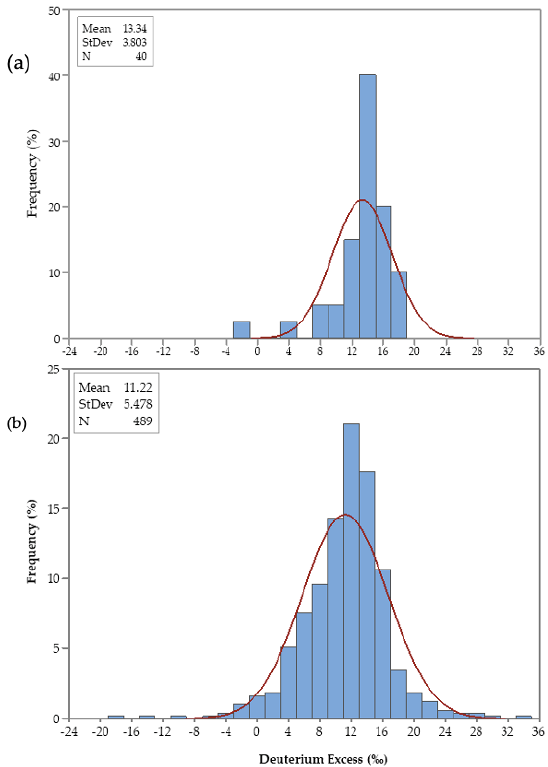
Figure 6. Frequency distribution of deuterium excess signatures for monthly precipitation from ( a ) MNIP stations over 2014 – 2019 and ( b ) surrounding GNIP stations for the period 1960 – 2016.